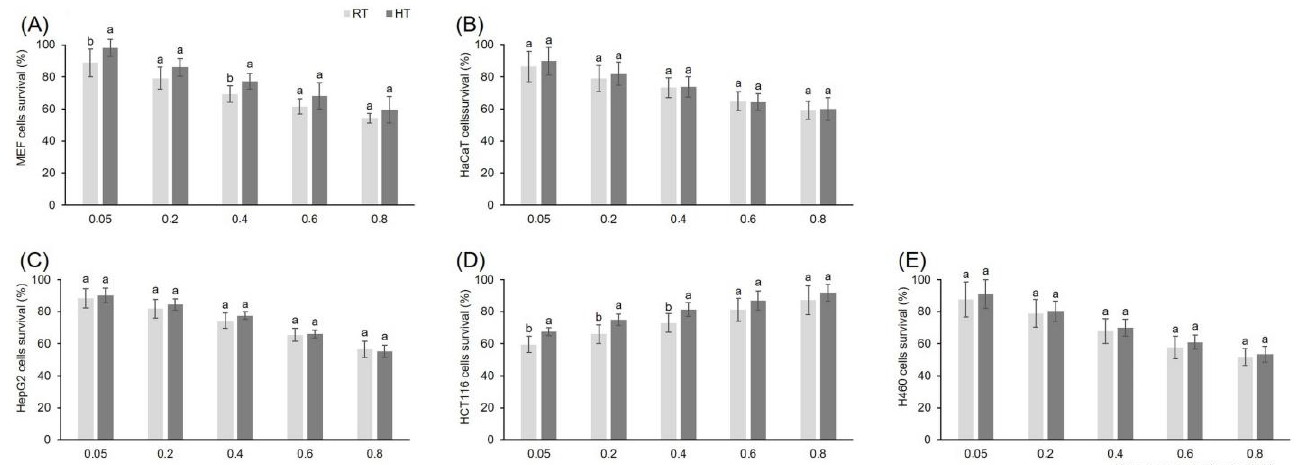
Figure 2. Viability of ( A ) MEF, ( B ) HaCaT, ( C ) HepG2, ( D ) HCT116, and ( E ) H460 cells measured by means of neutral red uptake after incubation with different concentrations of extracts of broccoli seedlings grown under room (RT) and high temperature (HT). Values represent mean ± standard deviation of three biological replicates and three technical replicas. Different letters indicate a significant difference among the values for each extract concentration separately (ANOVA, Duncan’s test, p ≤ 0.05). MEF = mouse embryonal fibroblasts, HaCaT = normal human keratinocytes, HepG2 = hepatocellular carcinoma cells, HCT116 = colorectal carcinoma cells, and H460 = lung carcinoma cells.